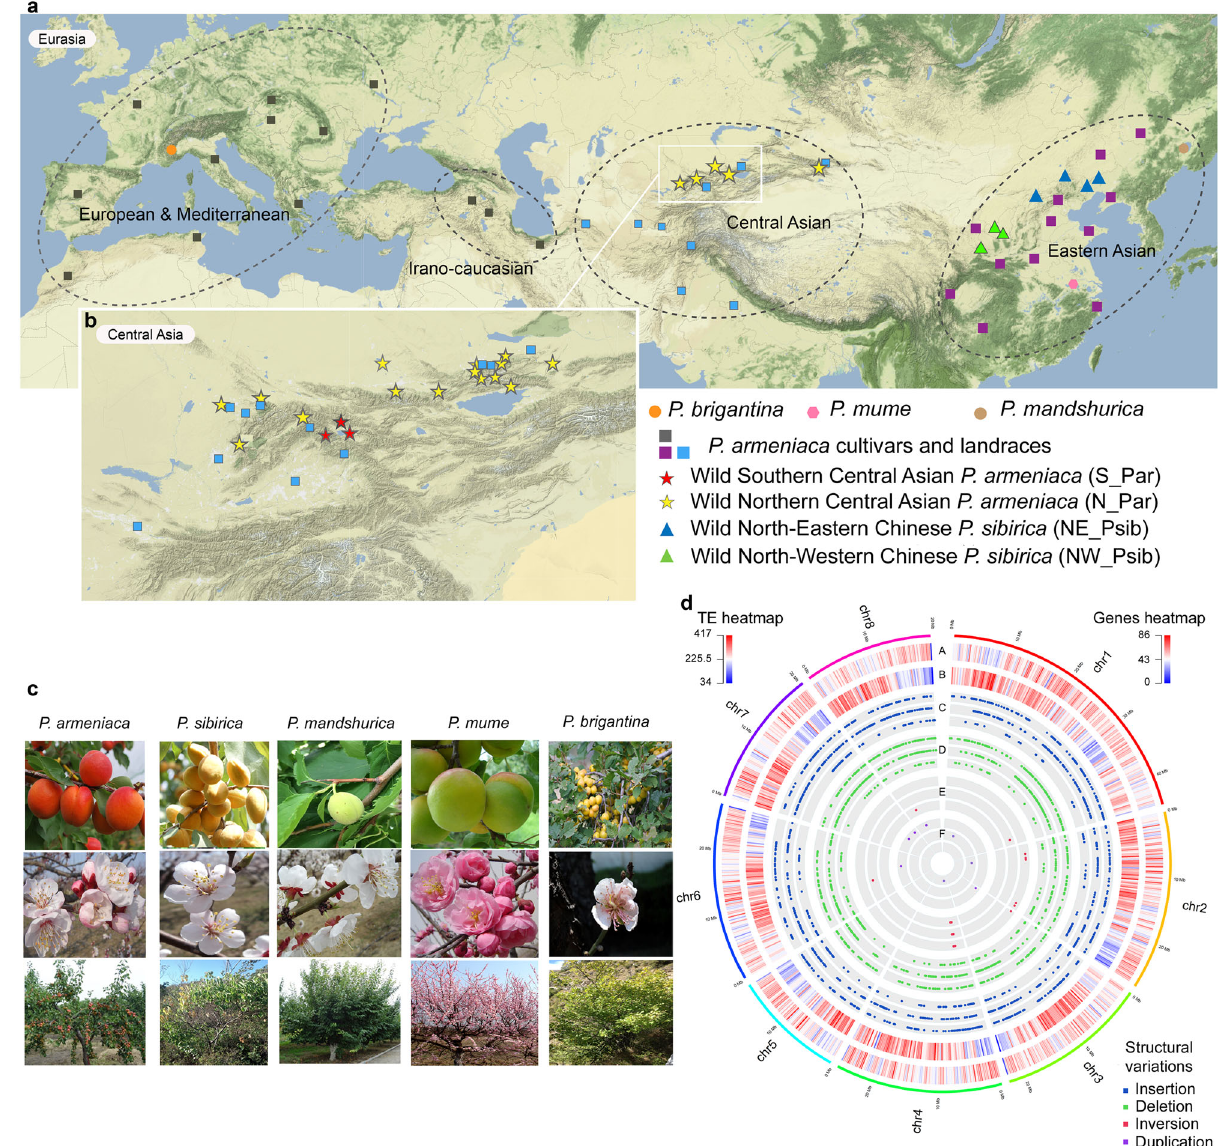
Fig. 1 Geographical distribution and features of Armeniaca species. a Map of species distribution and of plant material used in this study (Supplementary Data 1). The European and Irano-Caucasian cultivated apricots include 39 modern cultivars from North America, South Africa and New Zealand that are not represented on this map. Orange circles: P. brigantina , pink circles: P. mume , beige circles: P. mandshurica ; rectangles: P. armeniaca cultivars and landraces (European in grey, Chinese in purple, Central Asian in blue); red stars: wild Southern Central Asian P. armeniaca (S_Par); yellow stars: wild Northern Central Asian P. armeniaca (N_Par); blue triangles: wild Northern Eastern Chinese P. sibirica (NE_Psib); green triangles: wild Western Chinese P. sibirica (NW_Psib). b Close-up of the Central Asian Prunus armeniaca (Par) natural population. Northern P. armeniaca populations (N_Par) are located over the Zailiysky Mountains while Southern P. armeniaca (S_Par) populations lay over the foothills of the Ferghana valley. c Pictures of the species analysed. d Circos plot showing features of the Marouch #14 Prunus armeniaca genome. Outermost to innermost tracks show the gene density heat map in 250 kb bins ( a ), transposable element (TE, b ) density in 250 kb bins. The red color indicates higher density while the blue color indicates lower density. c – f represent structural variations (insertions in blue, deletions in green, inversions in red, and duplications in purple). For each track from ( c ) – ( f ), the outer layer corresponds to P. armeniaca cv. Stella, the middle layer to the P. sibirica CH320.5 and the inner layer to the P. mandshurica CH264.4 line. Maps are licensed as Creative commons for Stamen design. Pictures by S. Liu, S. Decroocq or licensed as Creative commons ( P. brigantina fl ower). The picture of cv. Sefora apricot ( P. armeniaca ) fruits was kindly provided by CEP INNOVATION. Source data underlying Fig. 1d are provided as a Source Data fi le and in Supplementary Data